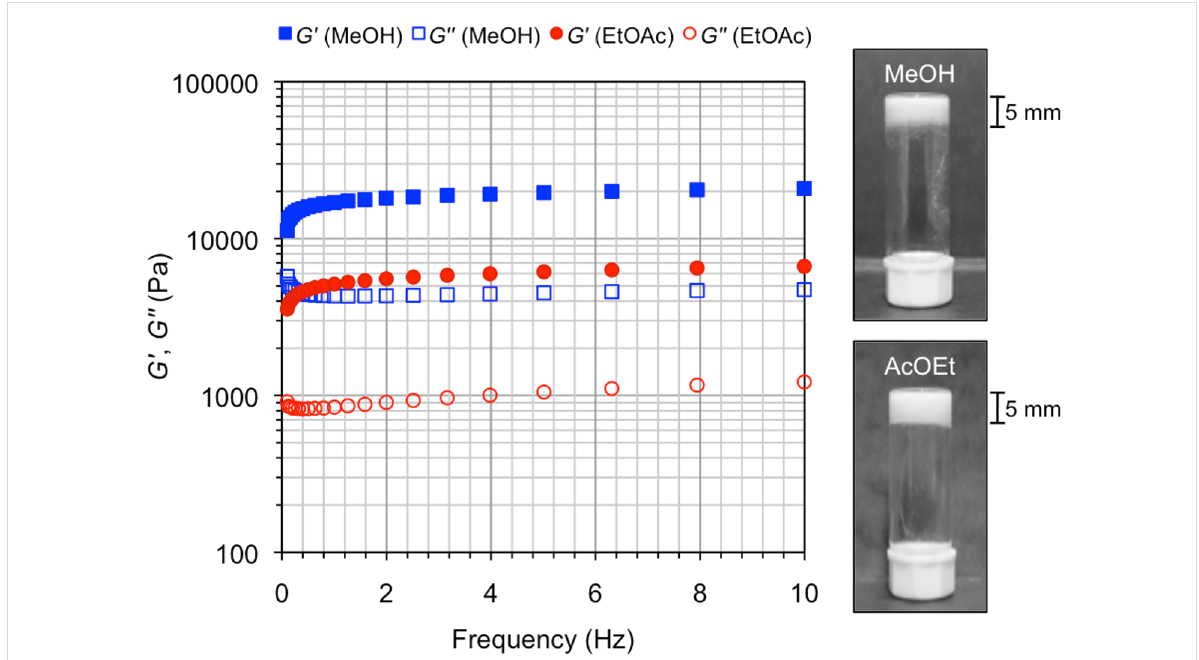
Figure 3: DFS measurements for model gels made of 3 in methanol ( c = 47 g/L) and ethyl acetate ( c = 36 g/L). Photographs on the right correspond to upside-down vials having the selected gels.